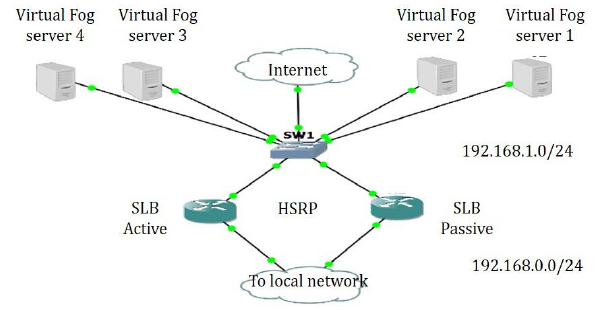
Figure 10. Virtual network using GNS3 and VirtualBox inside Fog server